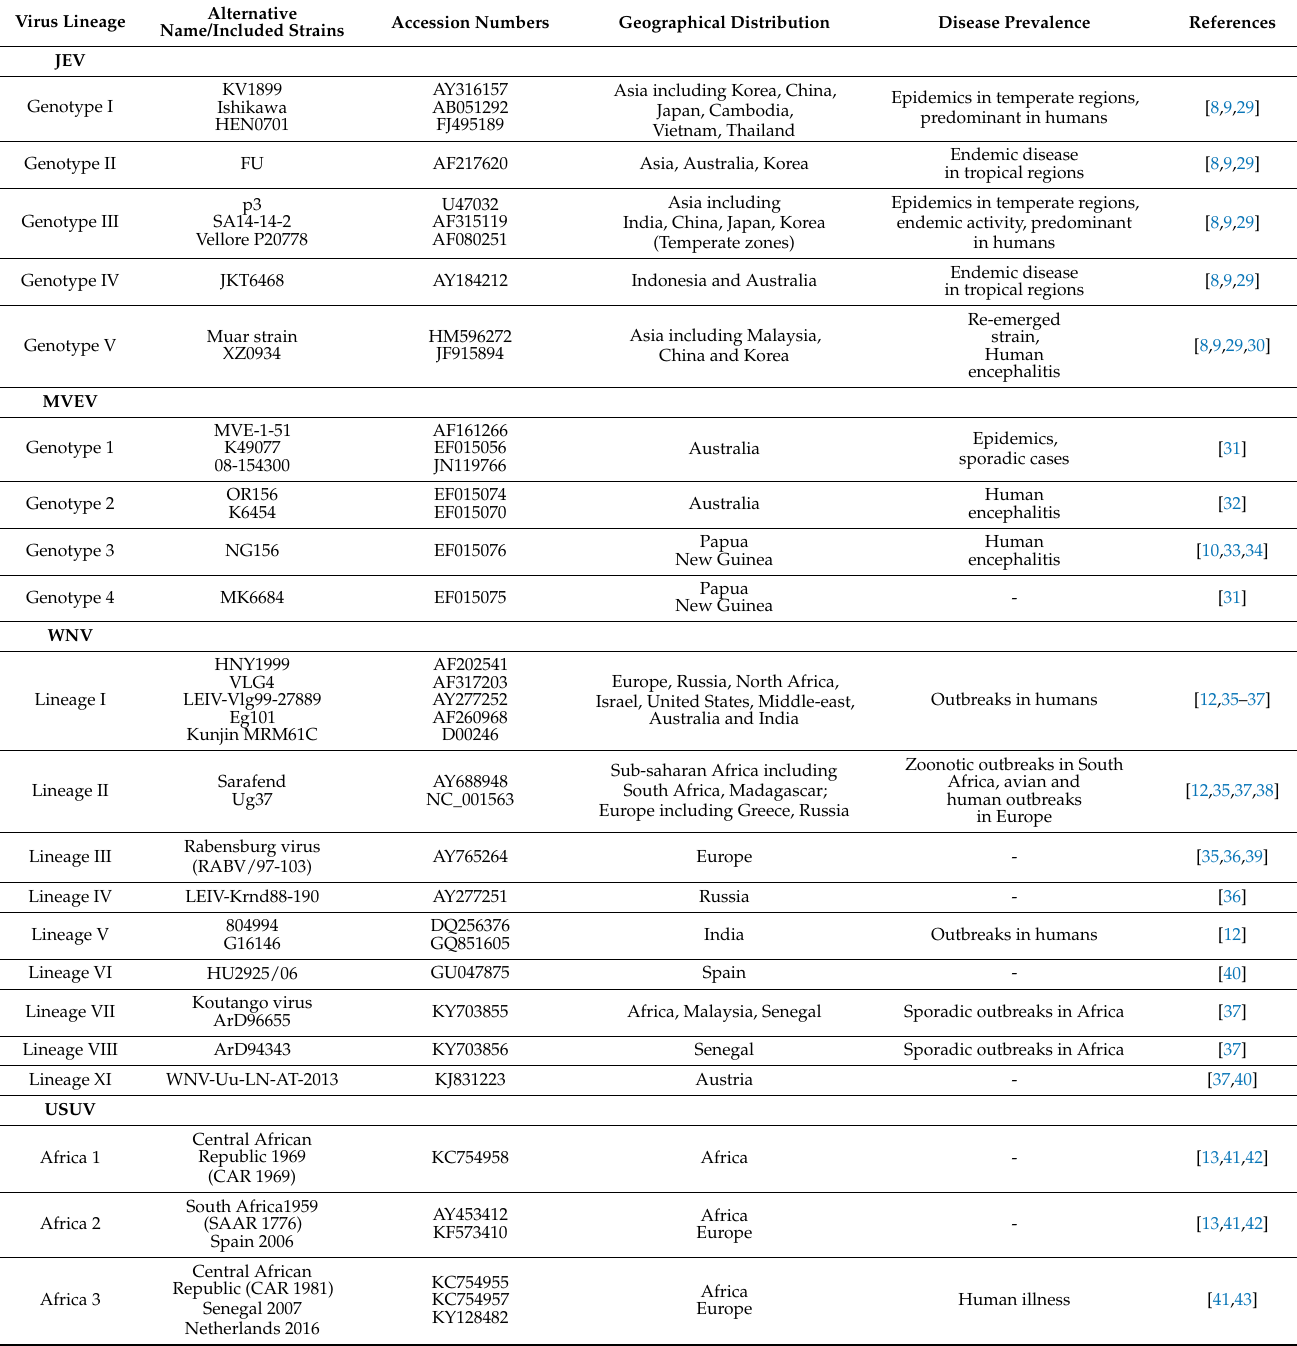
Table 2. Listed are the lineages of JEV, MVEV, WNV and USUV with a few representative